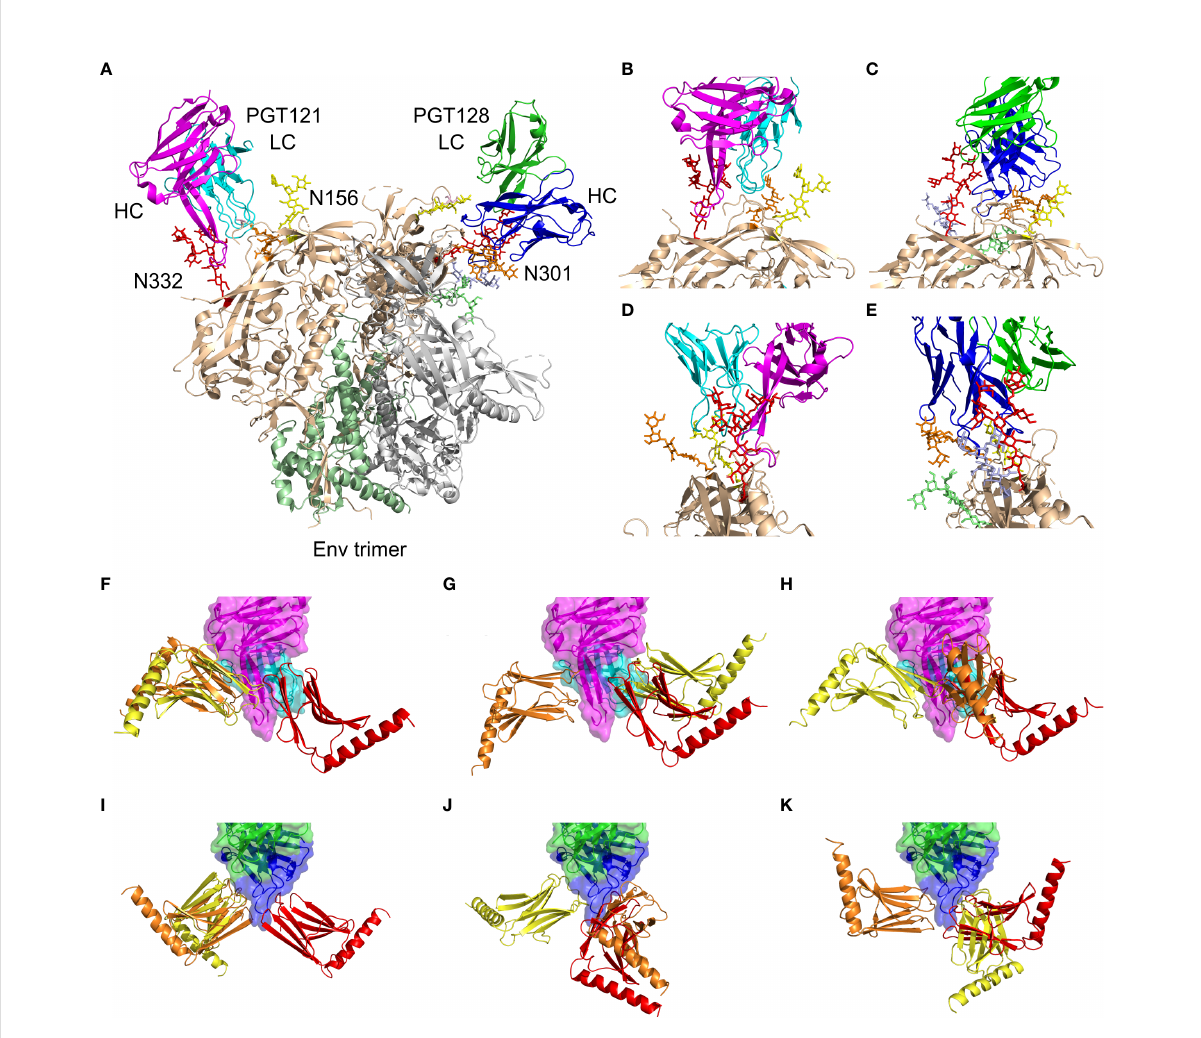
FIGURE 3 Summary of PGT121 and PGT126 interaction modes with the HIV-1 Env trimer and with reported Myomedin variants. (A) A collage of PGT121 precursor [5cez (33)] heavy chain (magenta) and the light chain (cyan) and the PGT128 [5aco (34)] heavy chain (blue) and the light chain (green) in complex with Env trimer showing gp41 (palegreen), gp120 (wheat), and the interacting glycans at N332 (red), N301 (orange), N156 (yellow), N262 (lime), and N295 (lightblue). (B, D) Enlarged and rotated view of the PGT121 interaction with gp120 (wheat) and glycans at N332 (red), N301 (orange), and N156 (yellow). (C, E) Enlarged and rotated view of the PGT128 interaction with gp120 (wheat) and glycans at N332 (red), N301 (orange), N156 (yellow), N262 (lime), and N295 (lightblue). (F – K) The predicted binding modes of Myomedin variants targeting PGT121 [4fqc (32)] heavy chain (magenta) and the light chain (cyan) are shown for (F) MLD033, (G) MLD068, and (H) MLD108. Similarly, the PGT126 [homology model built from PGT128 template, 5aco (34)] heavy chain (blue) and the light chain (green) binding modes are shown for (I) MLB036, (J) MLB041, and (K) MLB049. The typical binding modes color-coded by predicted binding probability in descending order from red through orange to yellow. A more detailed view is available in Supplementary Figures and PyMOL session at